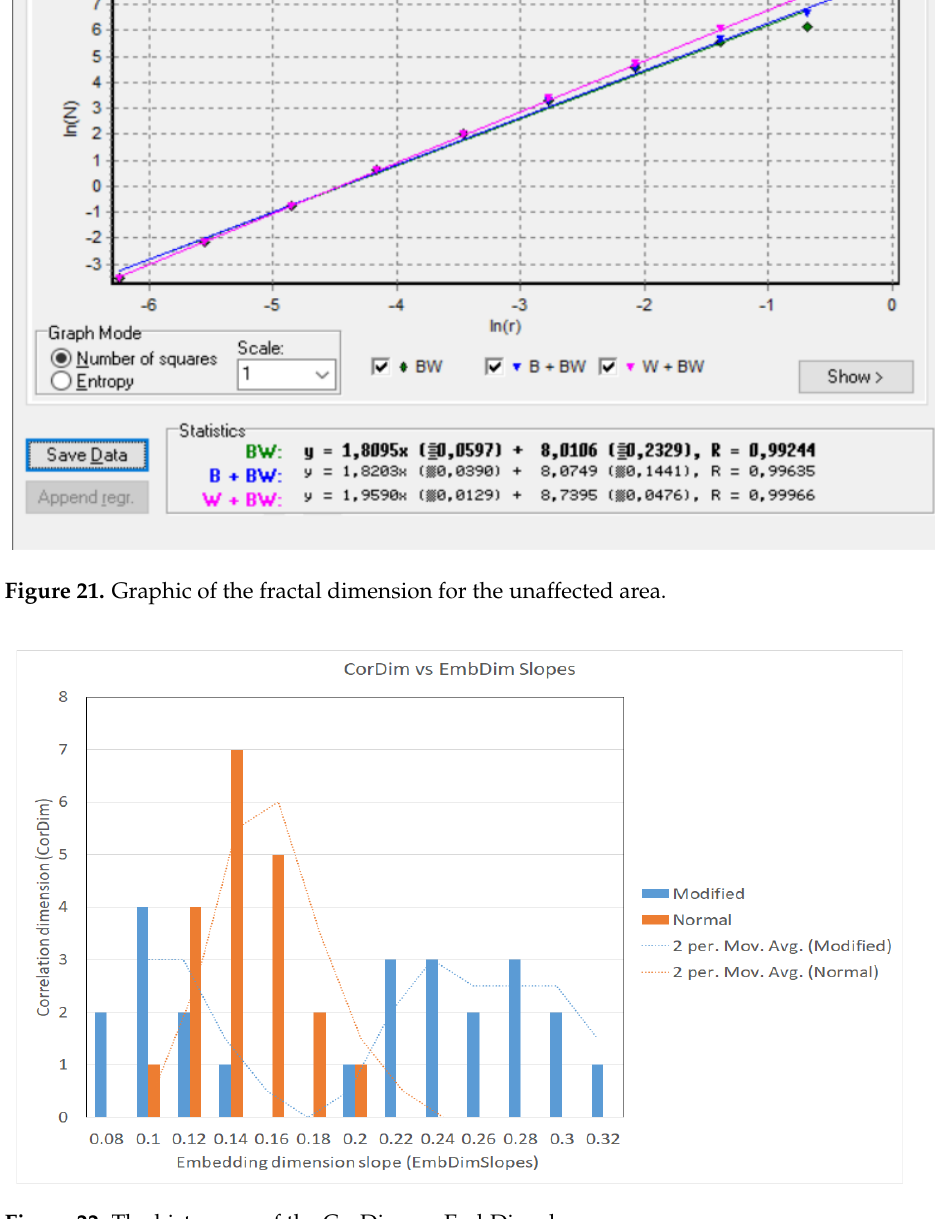
Figure 22. The histogram of the CorDim vs. EmbDim slopes.